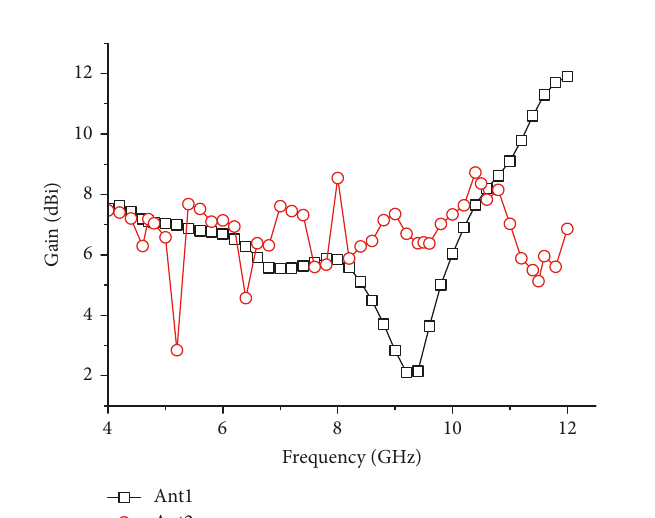
Figure 10: Far field pattern of (a) Ant1 and (b) Ant2.